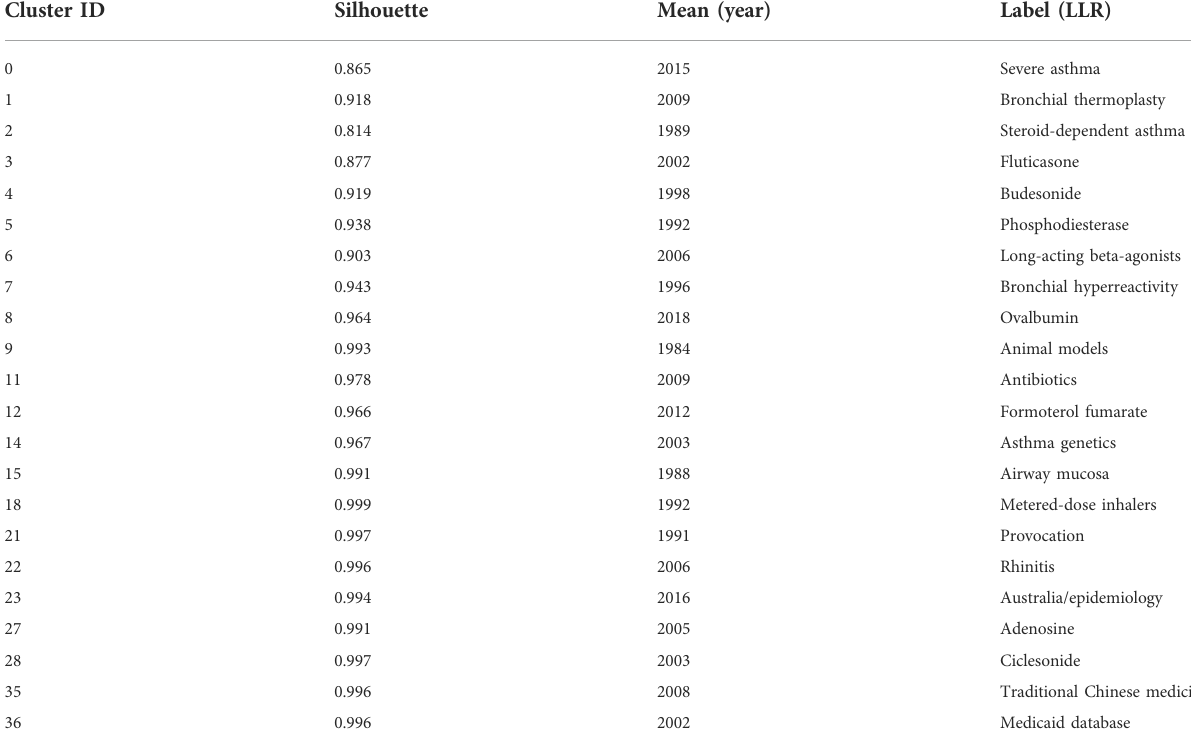
TABLE 8 Co-occurrence map of asthma drug-related studies co-cited reference cluster analysis.